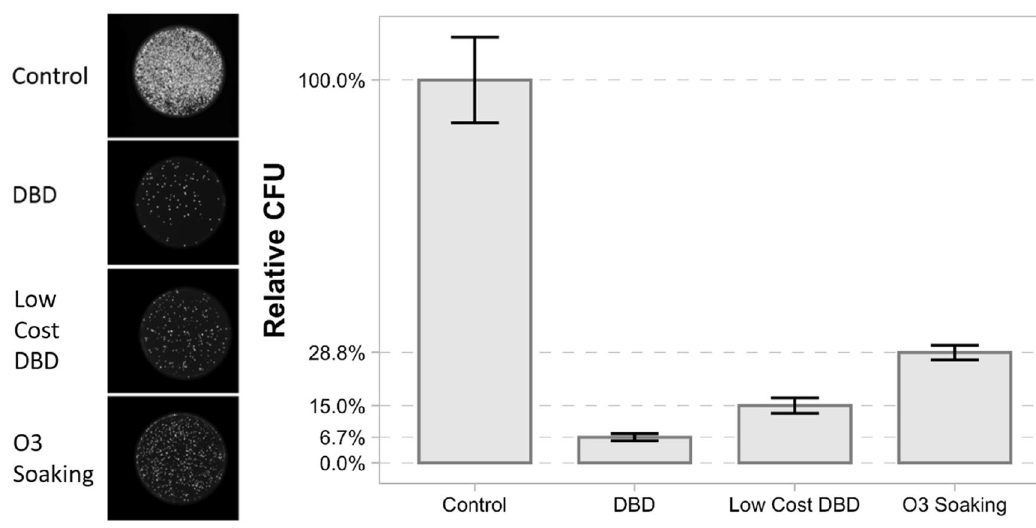
Figure 8. Decontamination efficacy using different configurations. The left inset shows fluorescent images of colony growth on agar after 32 min of treatment using different configurations. Right graph shows CFU values of different configurations relative to the negative control.